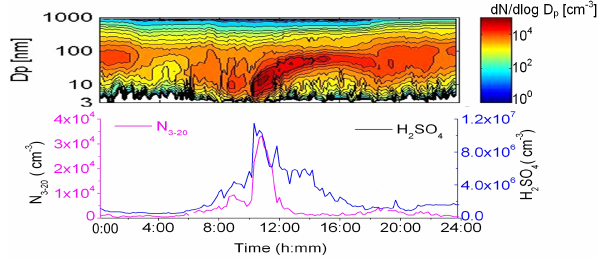
Fig. 1. Particle number size distributions, particle number concen- trations (3–20nm) and sulfuric acid concentrations on a NPF day, 12 August 2008 (Local Time).